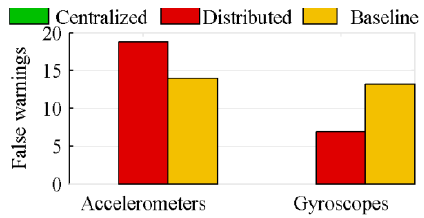
Figure 10. Detected faults for the algorithms considering sensors location.